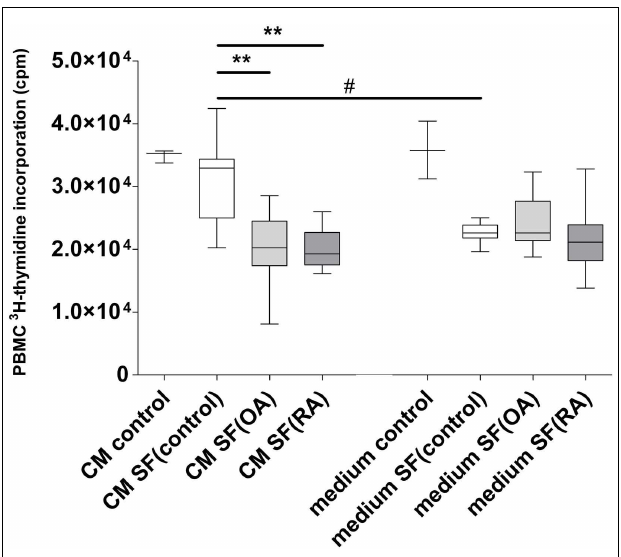
FIGURE 2 | Effect of conditioned medium of MSCs with different types of synovial fluid (SF) on proliferation of CD3/28 activated PBMCs. Box-and-Whisker plot 2.5–97.5 percentile; * P < 0.05; ** P < 0.001; # P < 0.05 between CM and SF effect. CM, conditioned medium; SF, synovial fluid; (medium) culture medium with ITS; (CM control) MSC conditioned medium consisting of only culture medium with ITS; (Medium control) Only culture medium with ITS; SF (control) synovial fluid of donors without joint pathology; SF(OA) synovial fluid of patients with osteoarthritis; SF(RA) synovial fluid of patients with rheumatoid